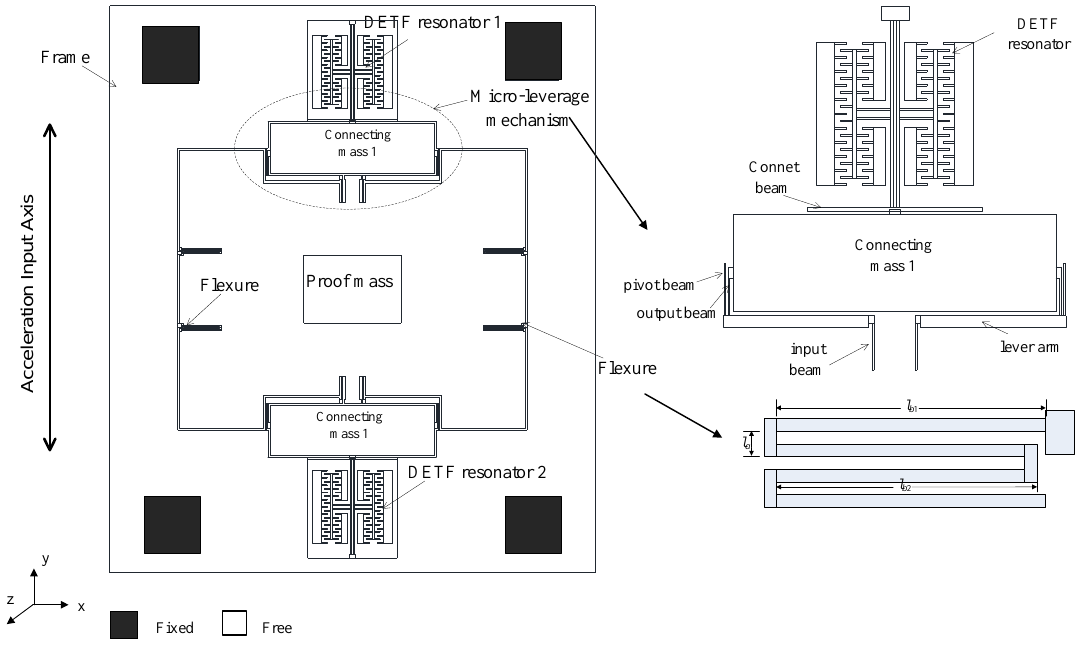
Figure 1. Schematic view of the SMRA with a frame structure.